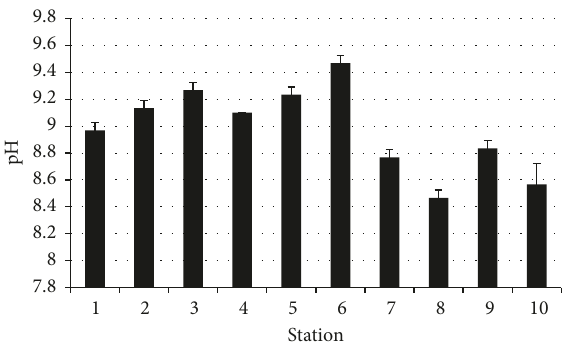
Figure 8: Mean pH from every station.